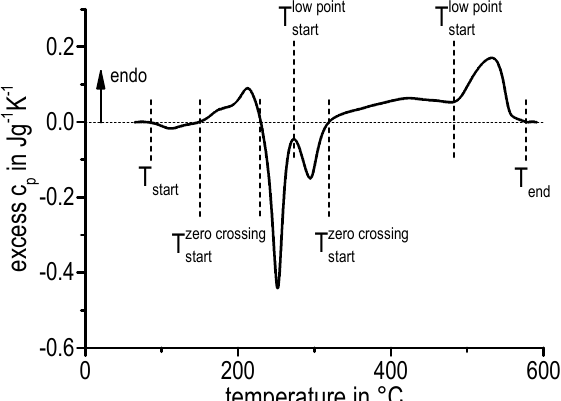
Figure 4. Separation of the individual peaks and defining onset and endset temperatures